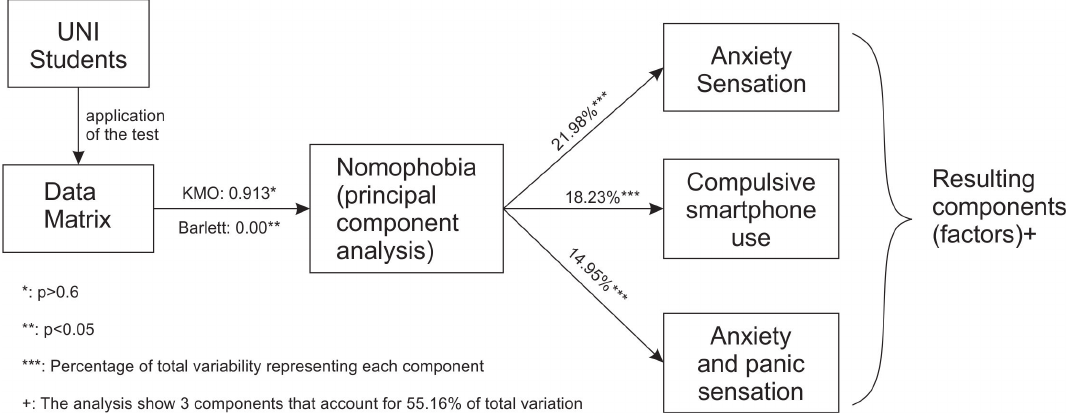
Figure 2. Structural model and results of applied